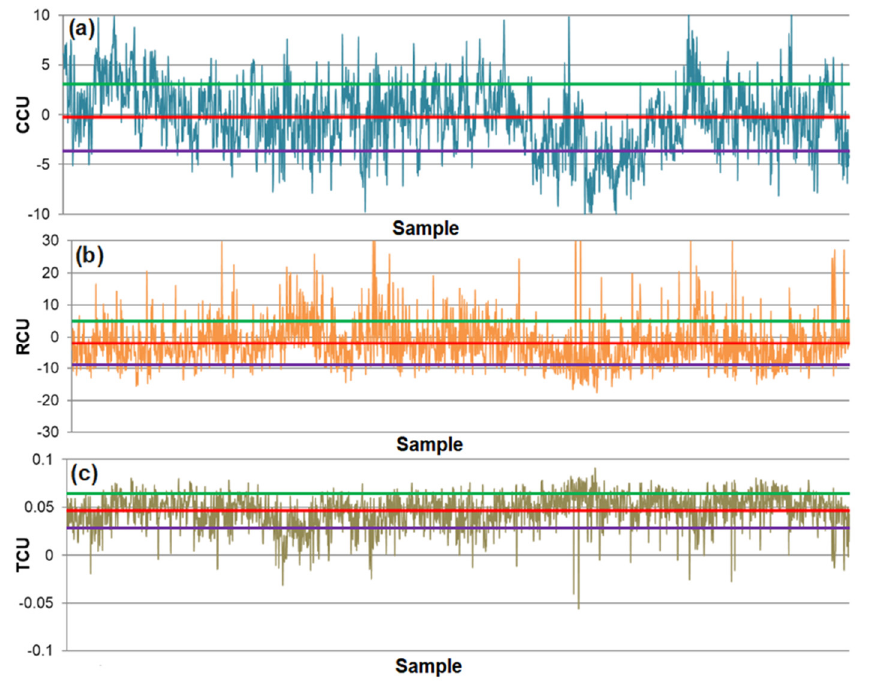
Figure 17. Prediction errors of technological indicators according to the PSM model: ( a ) CCU, ( b ) RCU and ( c ) TCU. The red line on the charts represents mean (μ), green line value μ + 1 SDE and RCU and ( c ) TCU. The red line on the charts represents mean ( µ ), green line value µ + 1 SDE and purple line value μ − 1 SDE. purple line value µ − 1